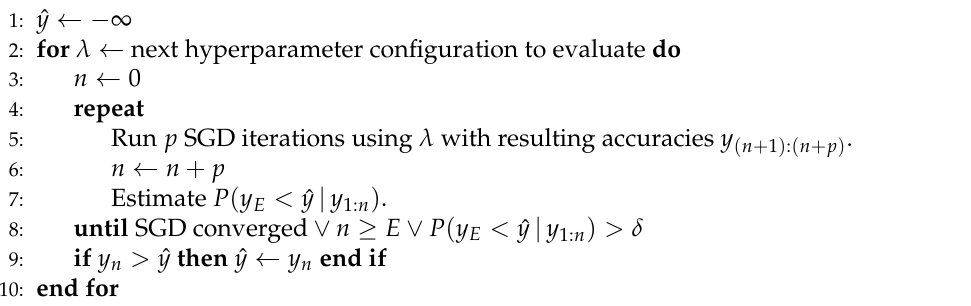
Algorithm 1 Extrapolation